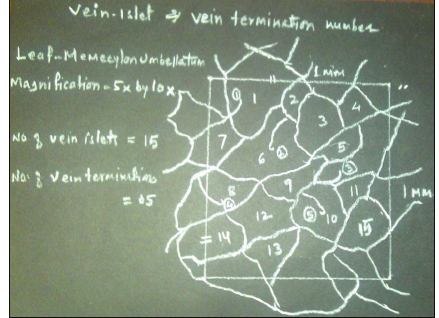
Figure 8: Diagram showing vein islet number and vein termination number.